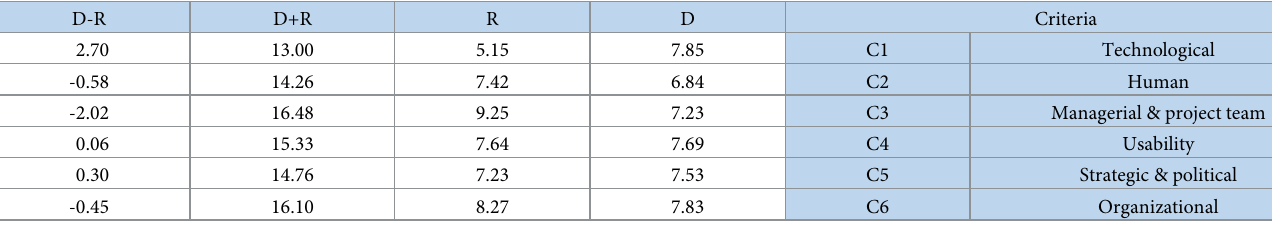
Table 8. The pattern of affecting and being affected of the main